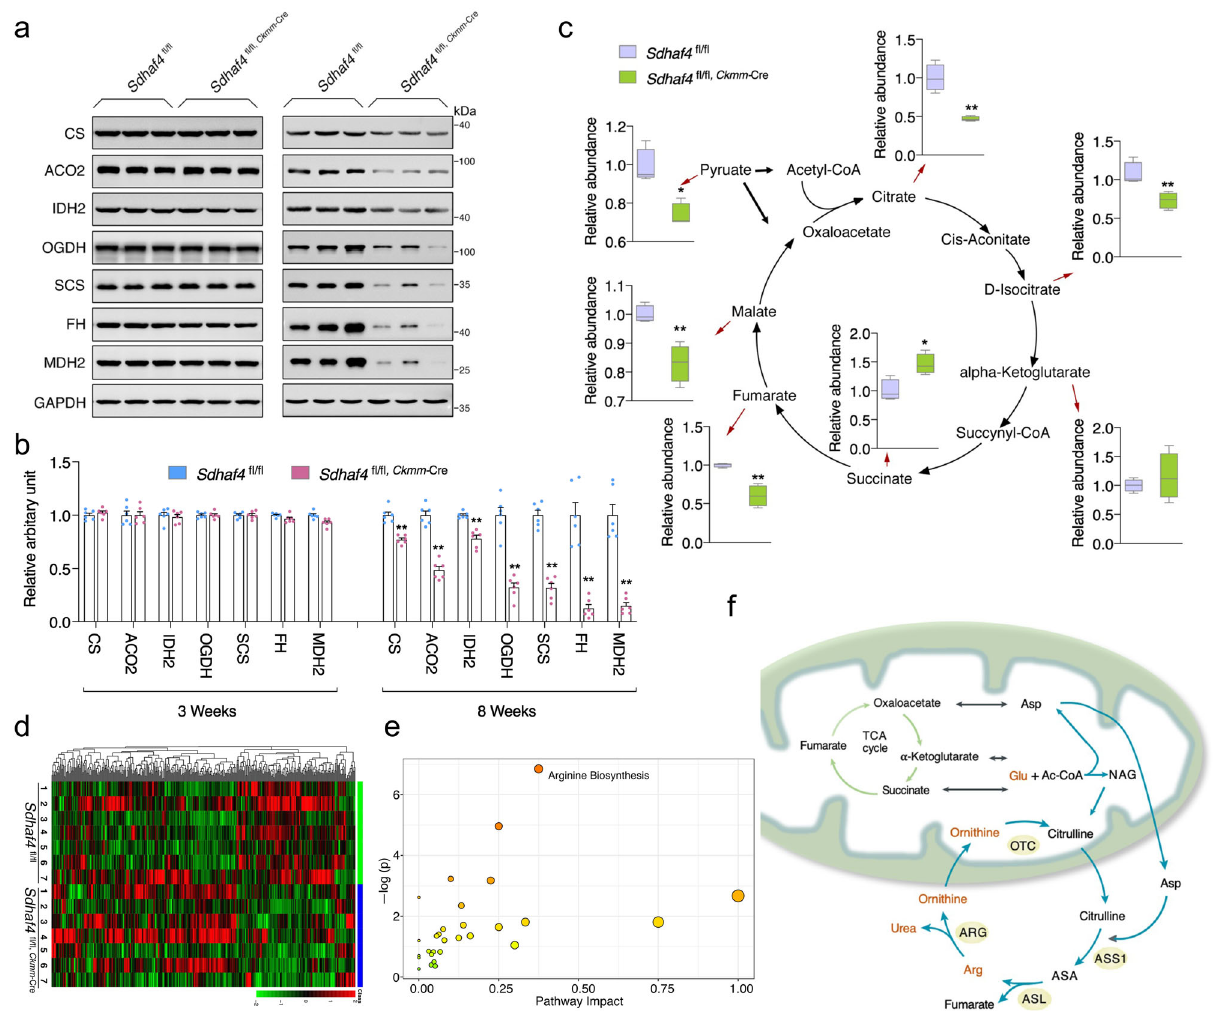
Fig. 5 Loss of SDHAF4 exacerbates TCA cycle-associated metabolic capacity. a , b Immunoblots for TCA cycle enzymes in left ventricles of hearts from WT and Sdhaf4 mutant mice at age of 3 and 8 weeks respectively, representative blotting images ( a ), summary analysis of arbitrary unit ( b ), n = 6, P < 0.0001. c Quantitative measurements of TCA cycle metabolites pyruvate, malate, fumarate, succinate, citrate, isocitrate, and alpha-ketoglutarate ( n = 4, P = 0.012, 0.001, 0.0013, 0.009, 0.003). Box plots indicate median (middle line), 25th, 75th percentile (box), and 5th and 95th percentile (whiskers). d – f Metabolomics analysis for left ventricles of WT and Sdhaf4 mutant mice at age of 8 weeks, with Z -score plot of global metabolic pro fi les among all the samples ( d ), metabolic pathway enrichment analysis ( e ), and representative images of alterations on arginine biosynthesis pathway ( f , green arrows for TCA cycle; blue arrows for arginine biosynthesis pathway; red highlights decreased metabolites), n = 7. Values are mean ± SEM, * P < 0.05, ** P < 0.01. Statistical signi fi cance was determined by two-tailed Student ’ s t -test ( b , c ). Source data are provided in Source Data fi le. TCA cycle tricarboxylic acid